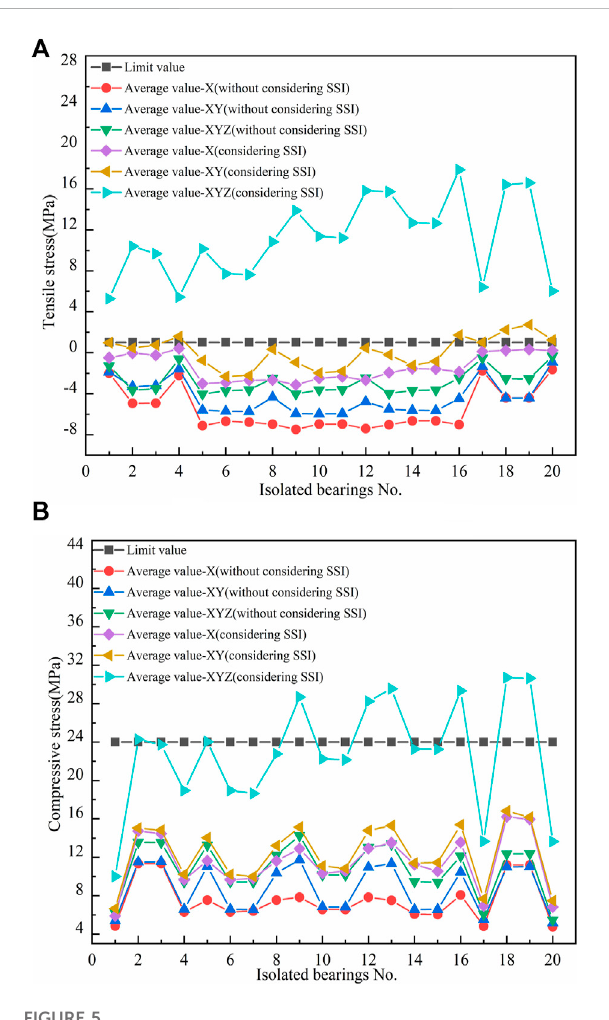
FIGURE 5 Stressofisolatedbearings. (A) Tensilestressofisolatedbearings. (B) Compressive stress of isolated